Question: Briefly state, in one sentence, what is plotted here.
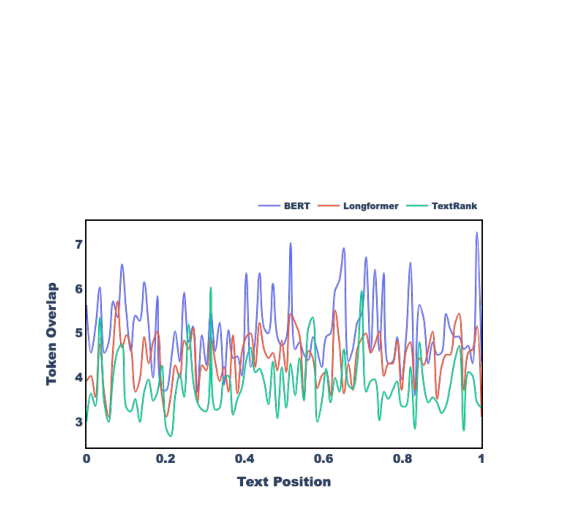
Answer: Average token overlap between shuffled system-generated summaries by each of the three ex- tractive summarization models and each document di in the input set D of DivSumm. Text position on the x-axis has been normalized between 0 and 1.